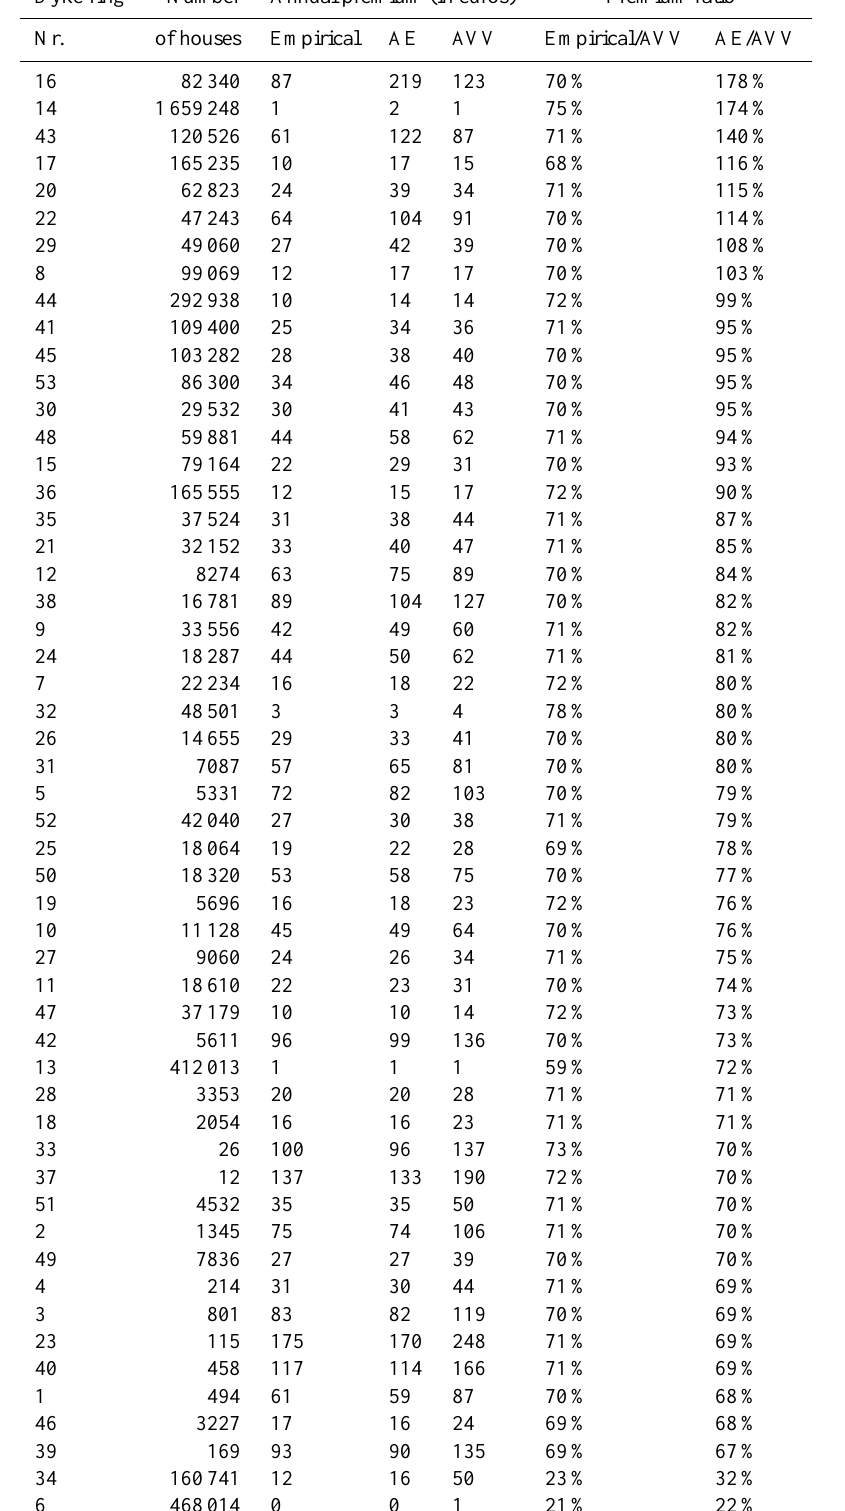
Table 4. Results of annual flood insurance premiums per homeowner per dyke ring, according to the Empirical method, the Actuarial Equivalence (AE) method, and the AVV